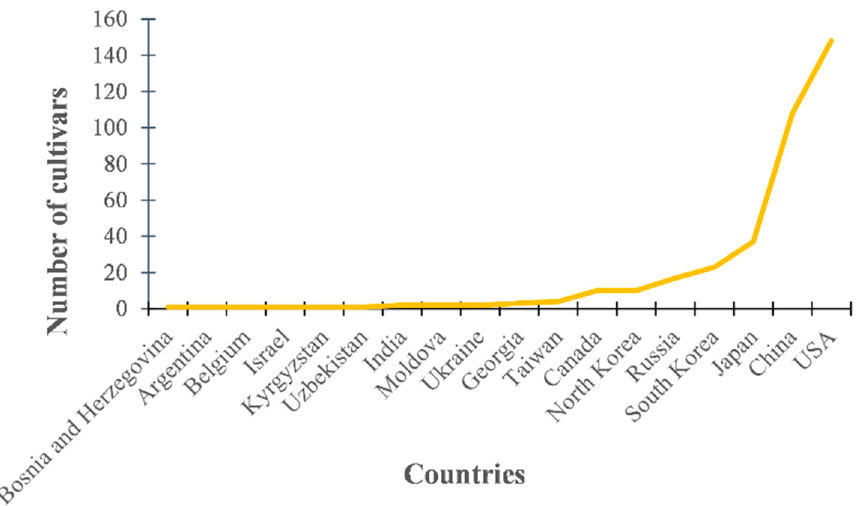
Figure 1. Variation in seed collection regions among 372 soybean cultivars selected for this study. Table 1. Analysis of variance (ANOVA) results from root morphological